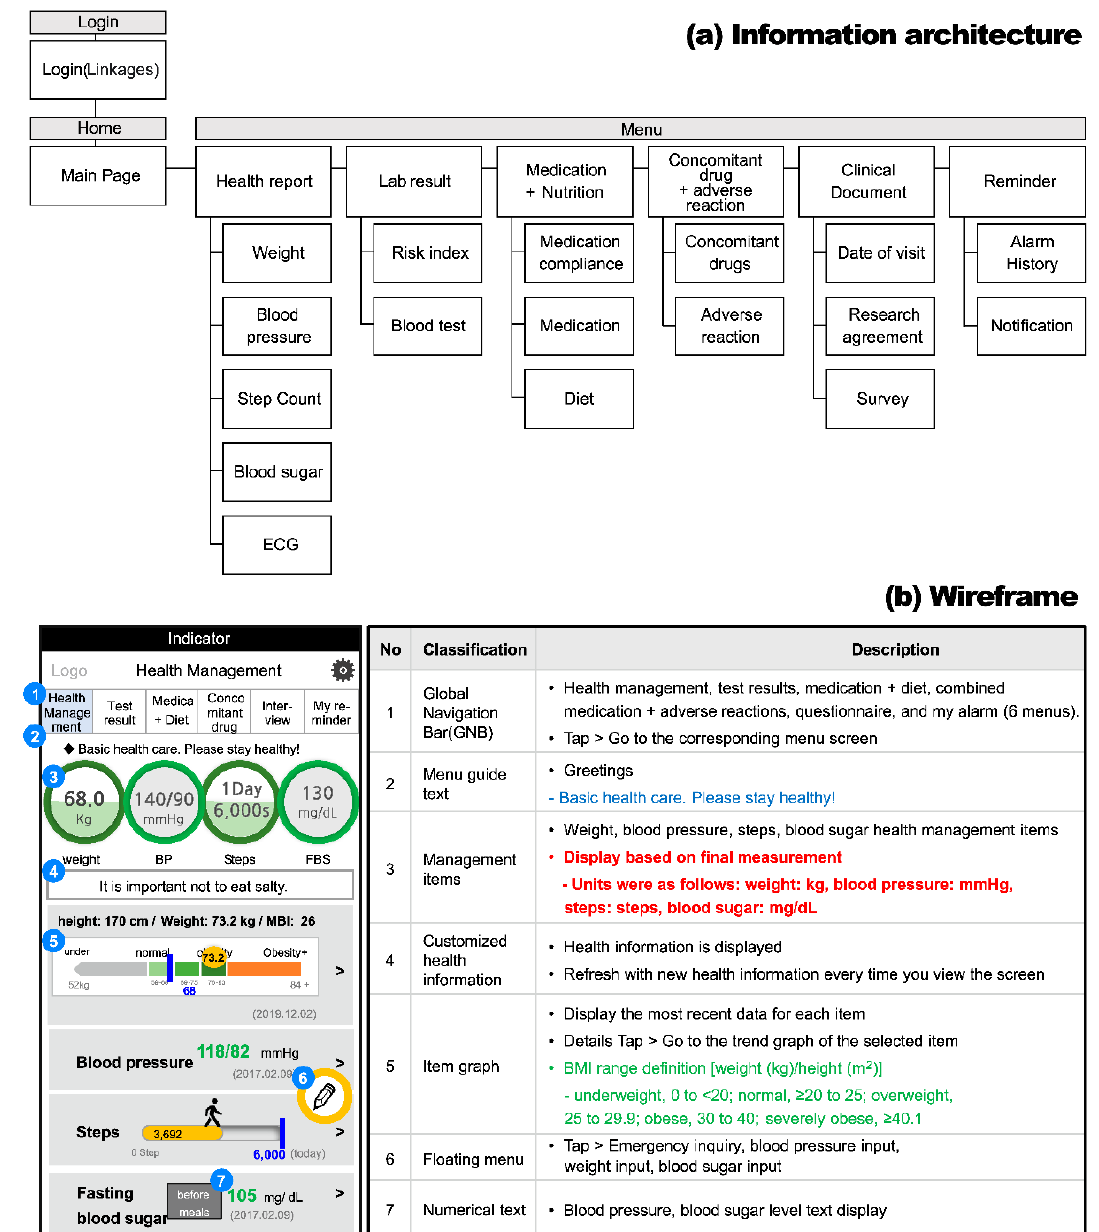
Figure 2. ( a ) Information architecture; ( b ) Wireframe. ECG, electrocardiogram. BMI, body mass in- dex.